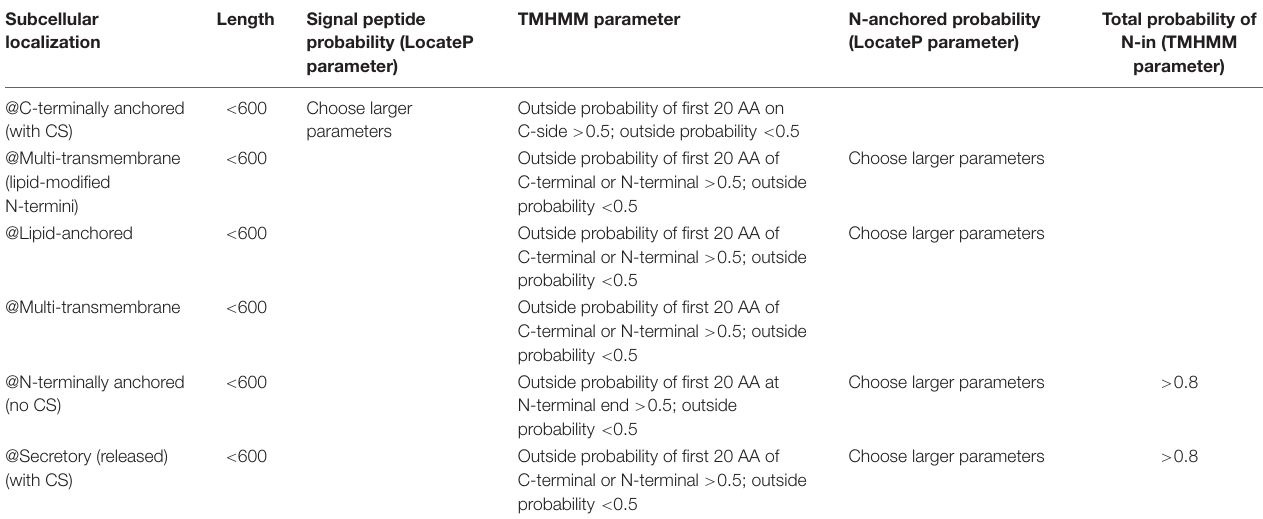
TABLE 2 | Screening criteria for potential anchor proteins in this